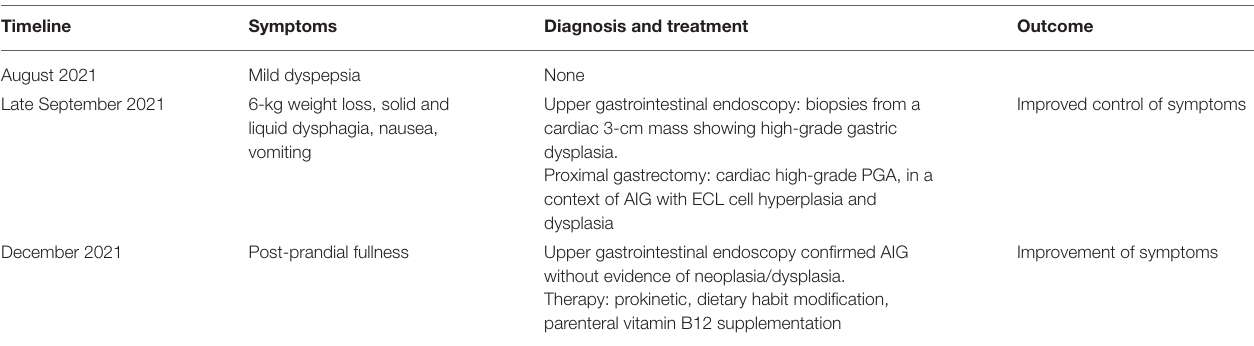
TABLE 1 | Timeline of the disease and